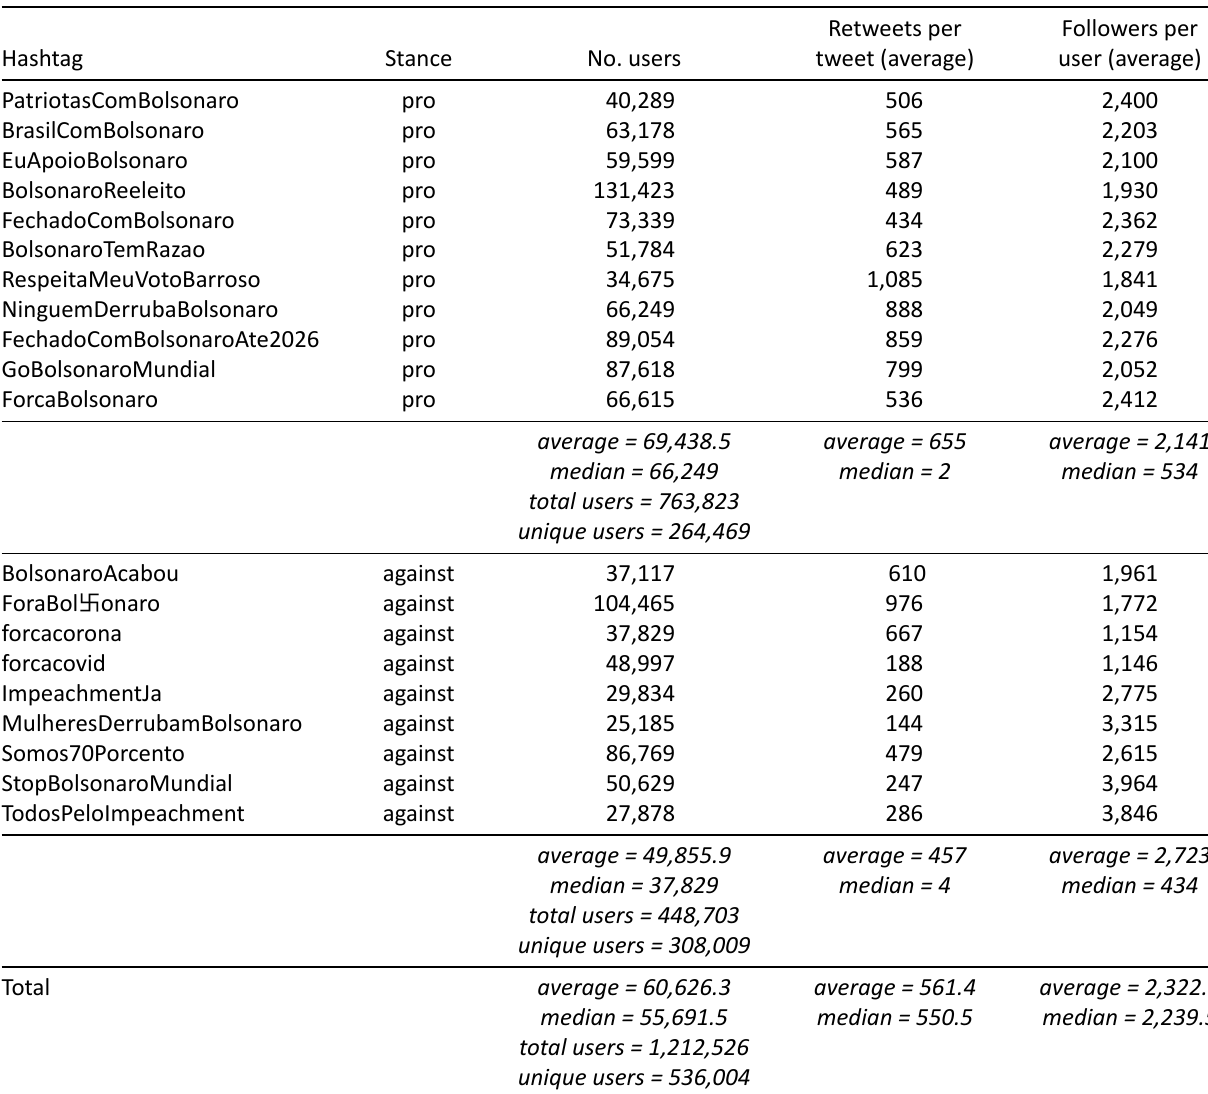
Table 2. User engagement metrics for